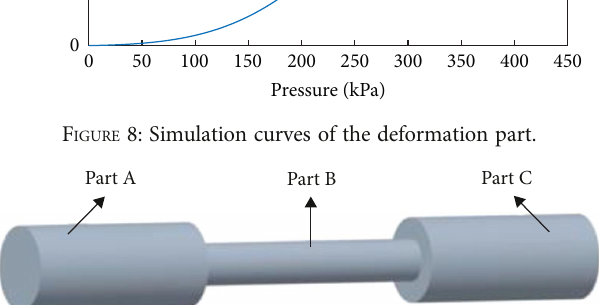
F IGURE 9: Schematic diagram of the pipe soft robot.